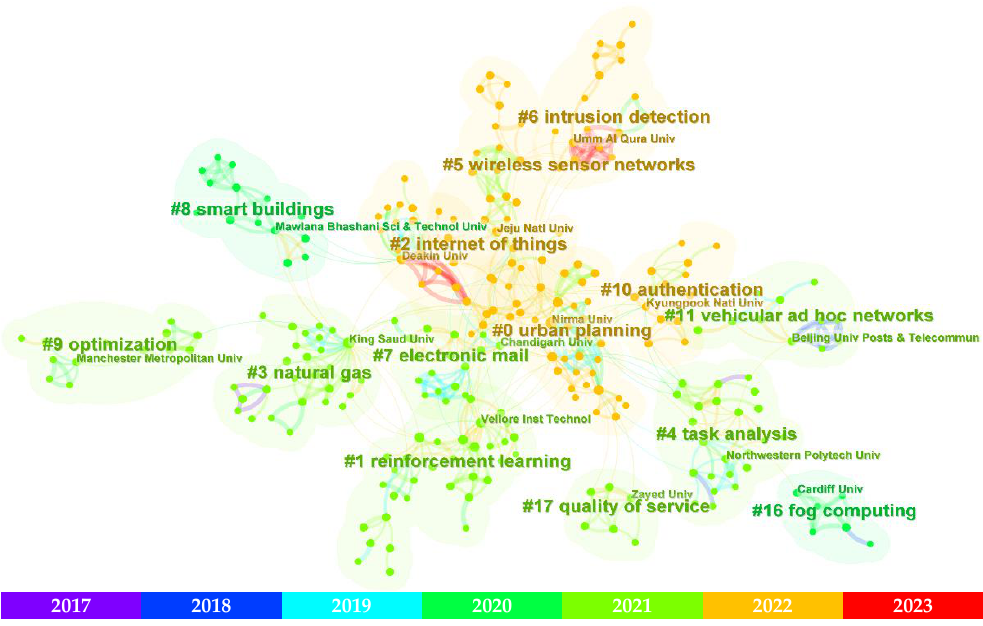
Figure 8. Largest co- authors’ institutions clusters in the subject field.